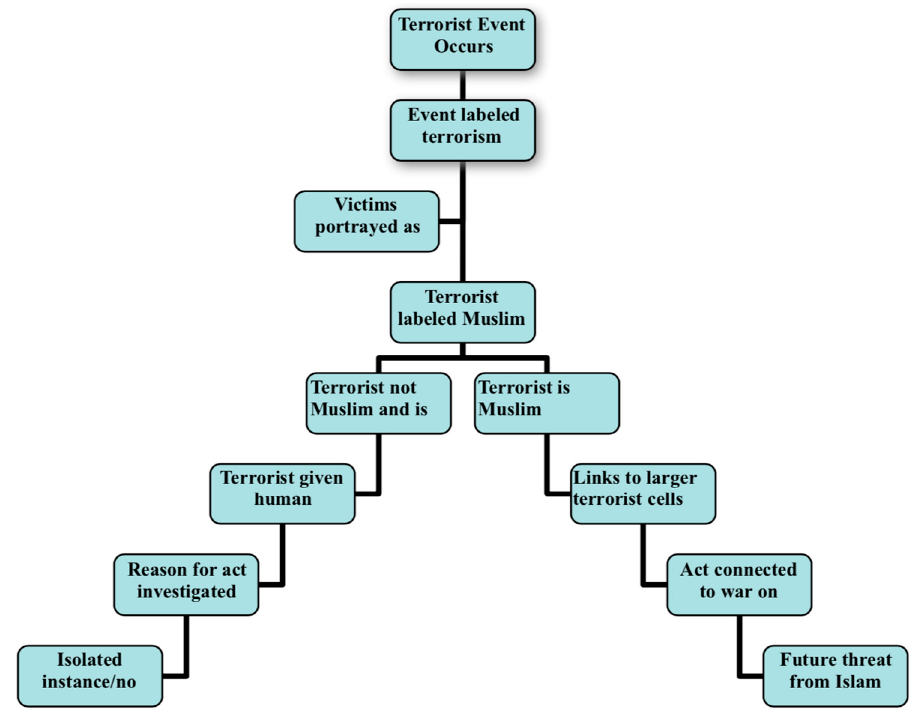
Figure 1. Model of media coverage of terrorist events in the U.S. (Powell